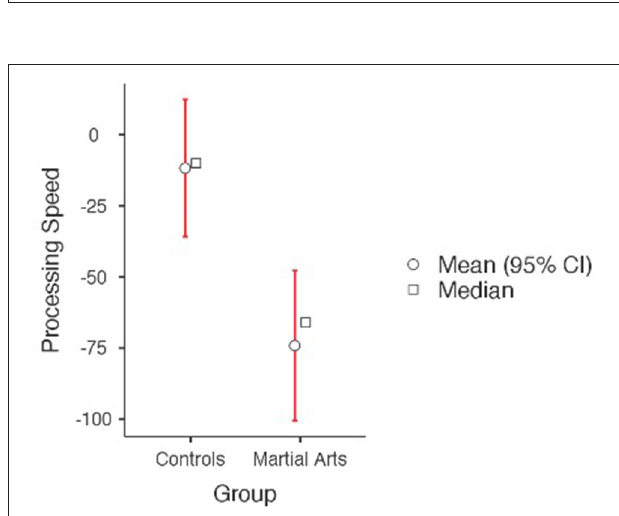
FIGURE 2 | Performance on CANTAB speed of processing task (higher scores reflect poorer performance). A significant group difference was found, p =